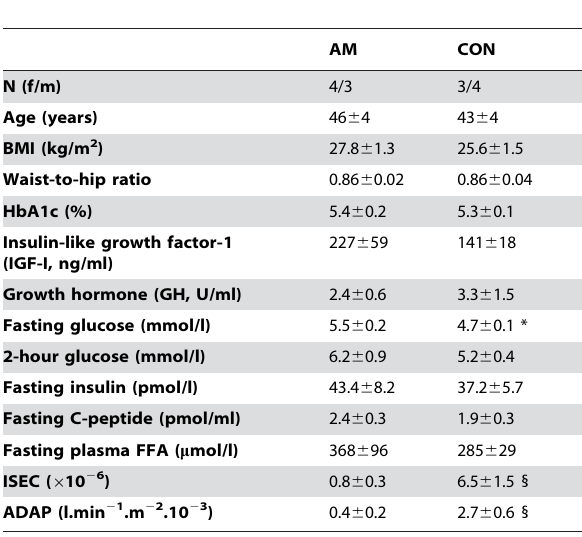
Table 1. Anthropometric and laboratory data (means 6 SEM) in subjects with prior acromegaly (AM) and controls